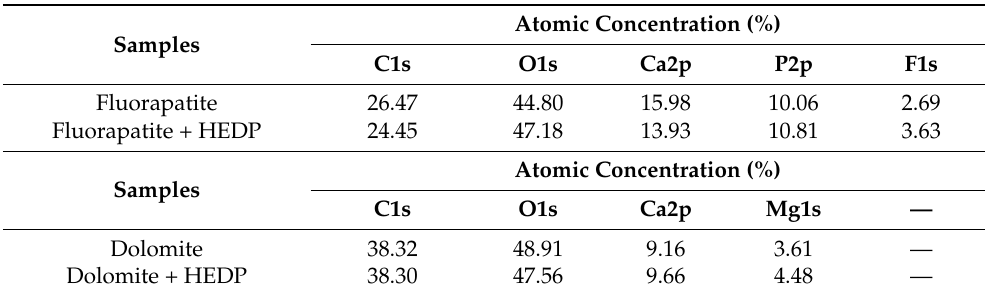
Table 1. Atomic concentrations of main elements on fluorapatite and dolomite surfaces treated with HEDP at pH